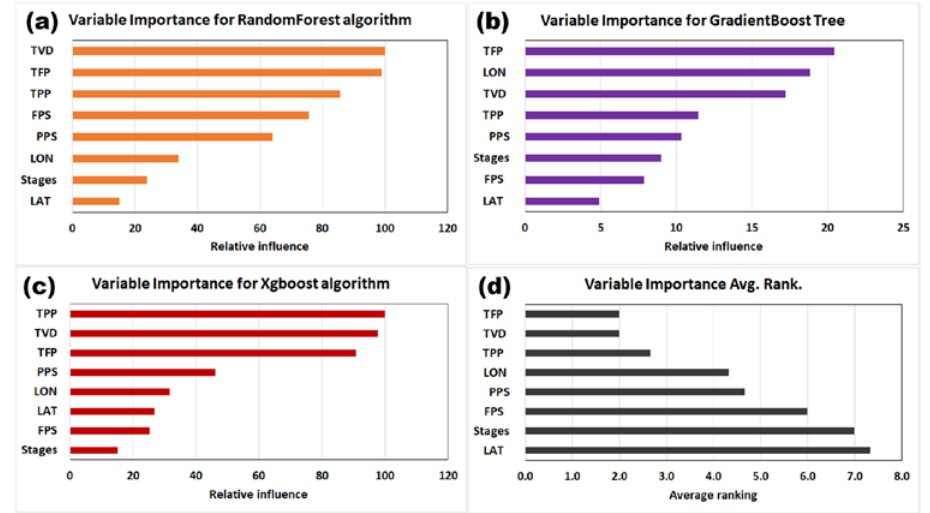
Figure 11. Variable importance analysis by machine learning algorithms. ( a ) RF; ( b ) GBM; ( c ) XGBoost; ( d ) the value of average rank of variable importance of CGP for 12 months.